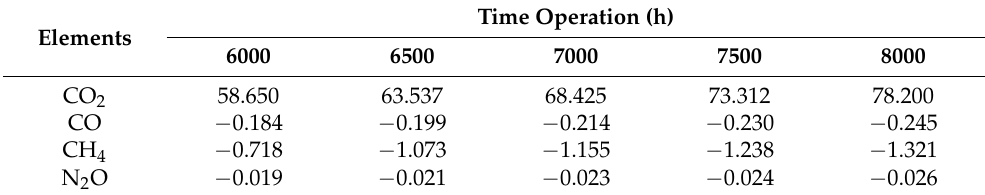
Table 11. Emission avoidance between coal- and rice straw-fired power plants. Elements